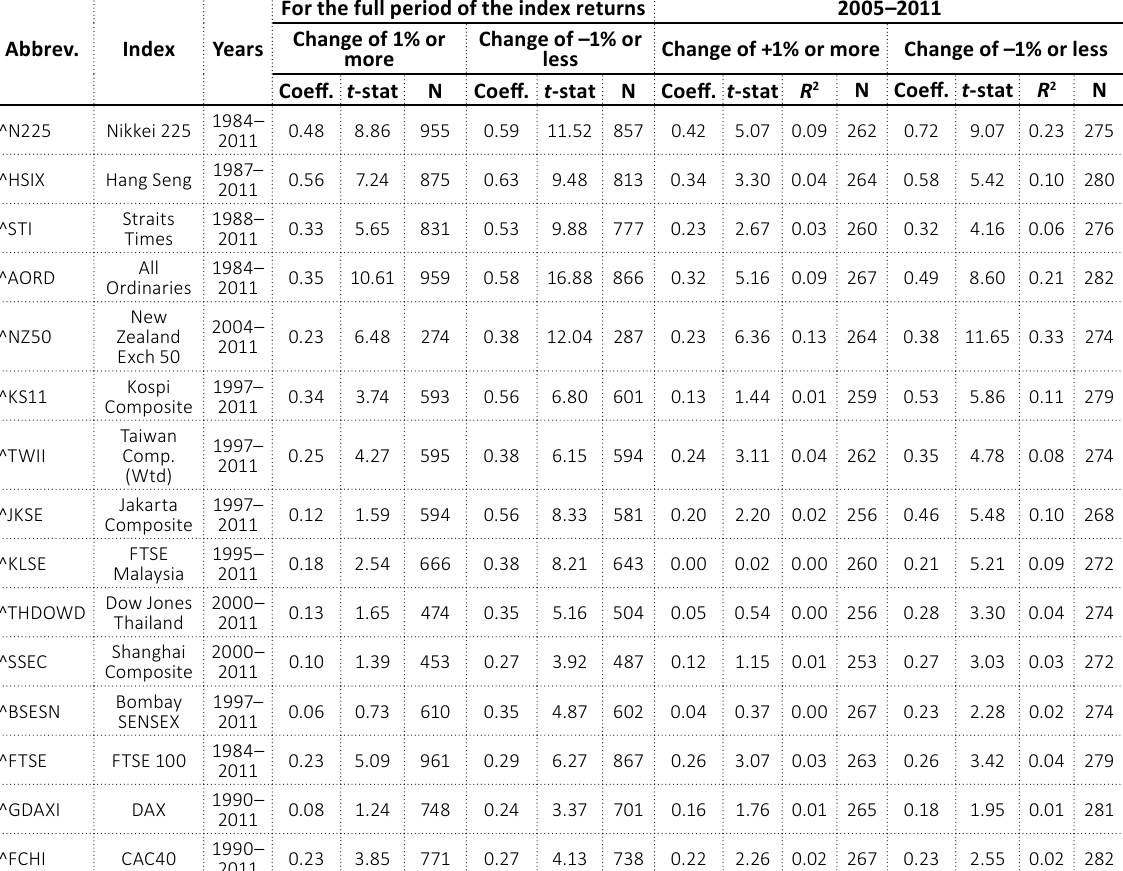
Table 5. Regression coefficients for regressing the foreign index on the S&P 500 index [e.g., Nikkei = f (S&P 500 225 t t +1